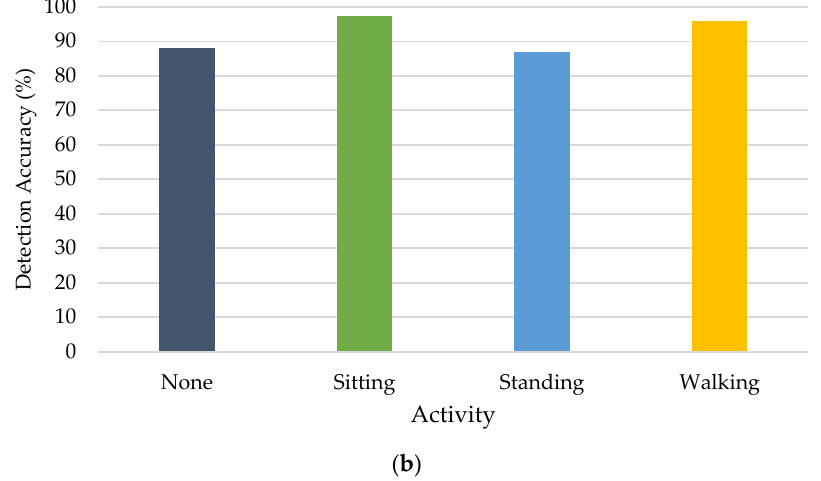
Figure 12. Occupancy activity detection performance results during the selected experimental test. ( a ) Percentage of time achieving correct, incorrect and no detections. ( b ) Performance results based on detection accuracy achieved for each response outcome of the detected activities; walking, standing, sitting and none.